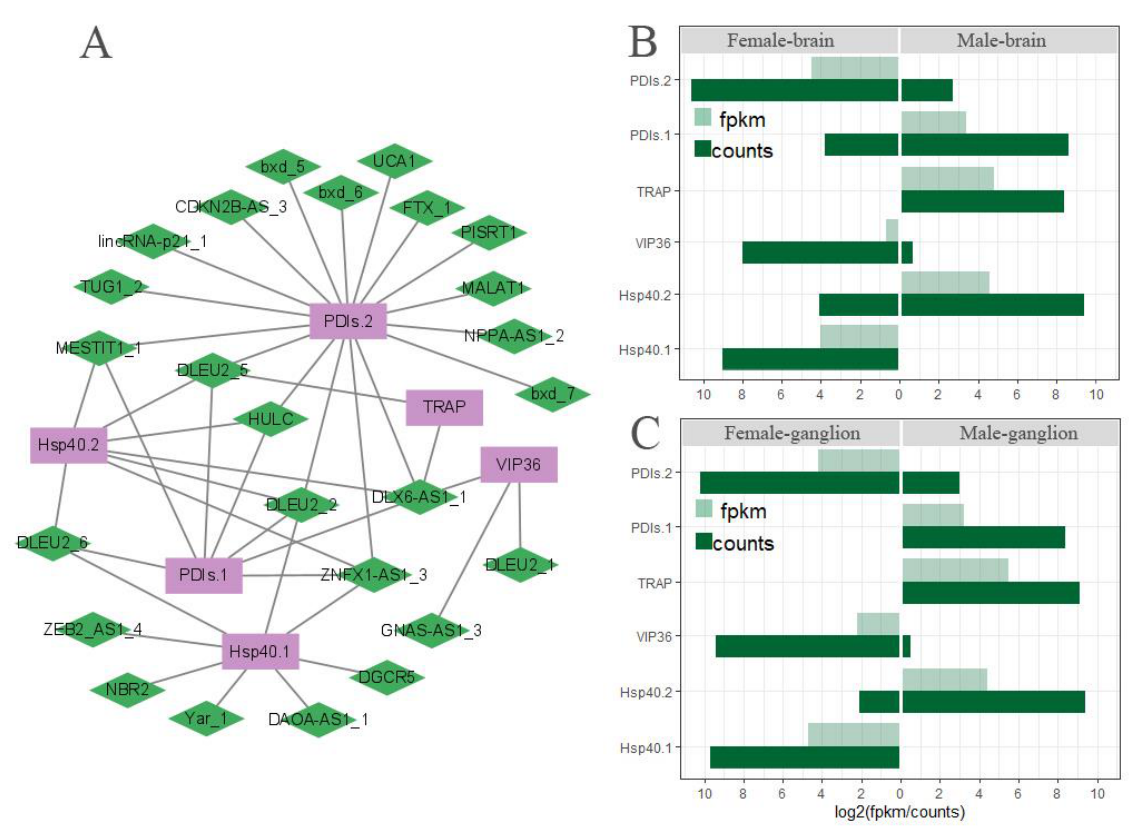
Figure 9. Differently expressed lncRNA and DEG co-expression networks ( A ) and absolute of log 2 (gene expression amounts) in sex-based brain ( B ) and ganglion ( C ) of M. rosenbergii . The purple rectangles represent genes; green diamonds represent lncRNAs. FPKM value was calculated using eXpress, and counts were calculated using bowtie2. FPKM indicates fragments per kilobase of transcript per million mapped reads.